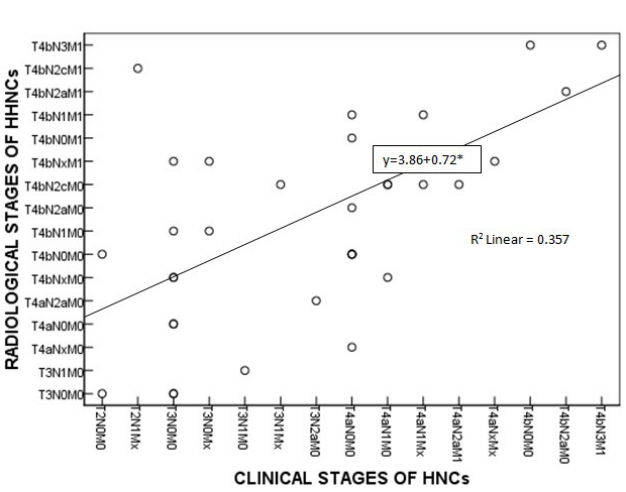
Fig. 2 - Correlation between clinical stages and radiological stages of